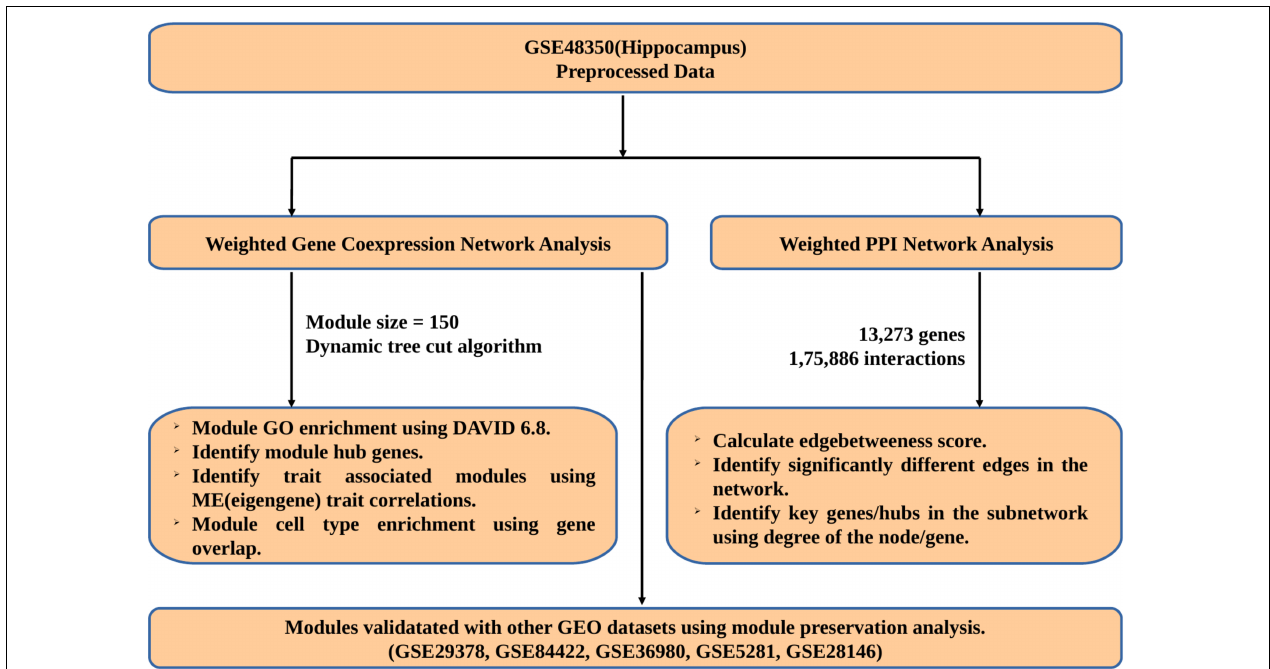
FIGURE 1 | Workflow used to study young, aging, and